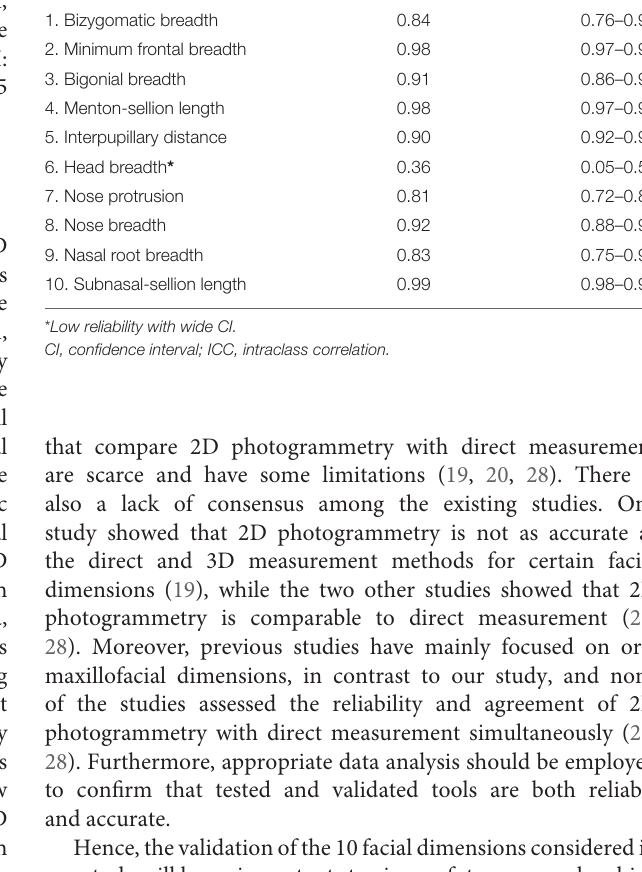
TABLE 3 | Summary of anthropometric statistics between direct measurement and 2D photogrammetry. Dimensions